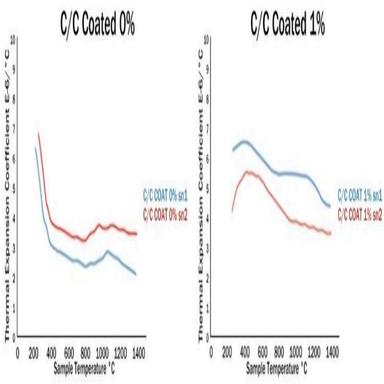
CTE behavior of C/C coated by Al2O3 naked varnish (left) and of C/C coated by Al2O3 enriched by 1 wt% of SiO2 nano-sphere inclusion (right).